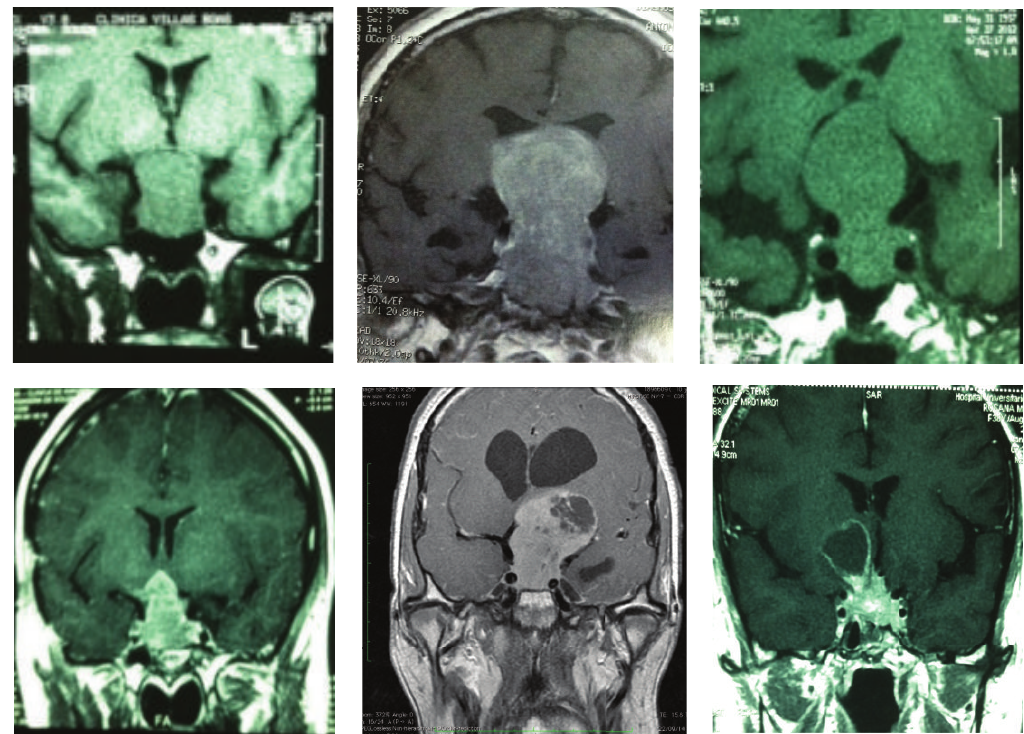
Figure 2: Radiological evaluation of aggressive pituitary tumors.